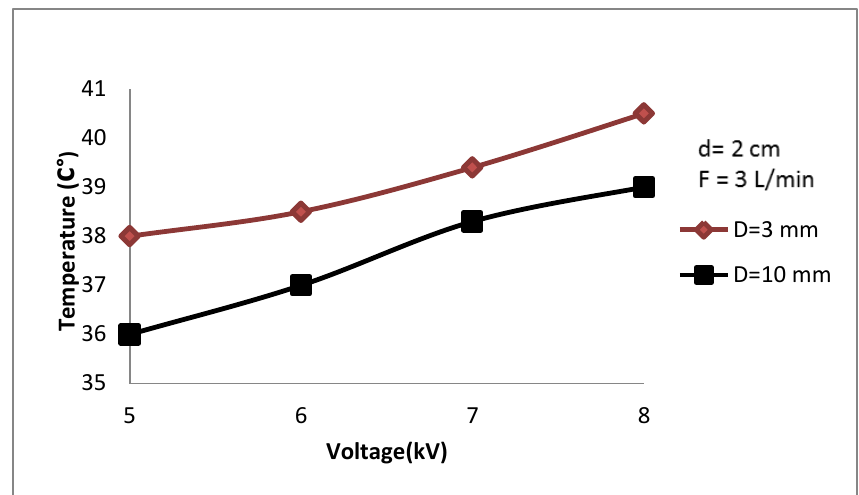
Fig.6: The relationship between voltages and